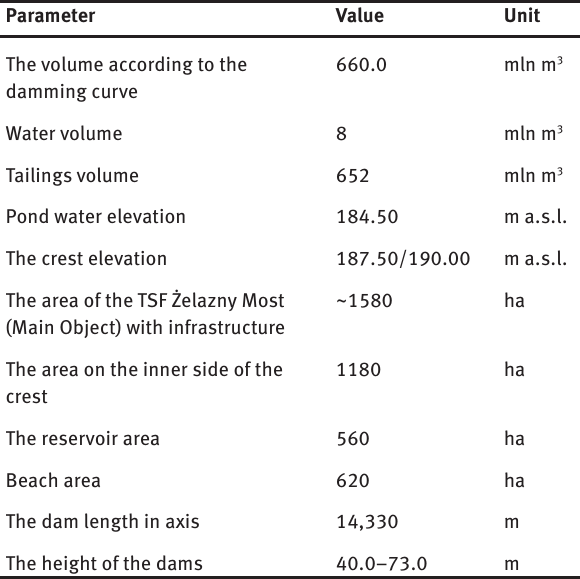
Table 1: Technical parameters of TSF Żelazny Most (last update